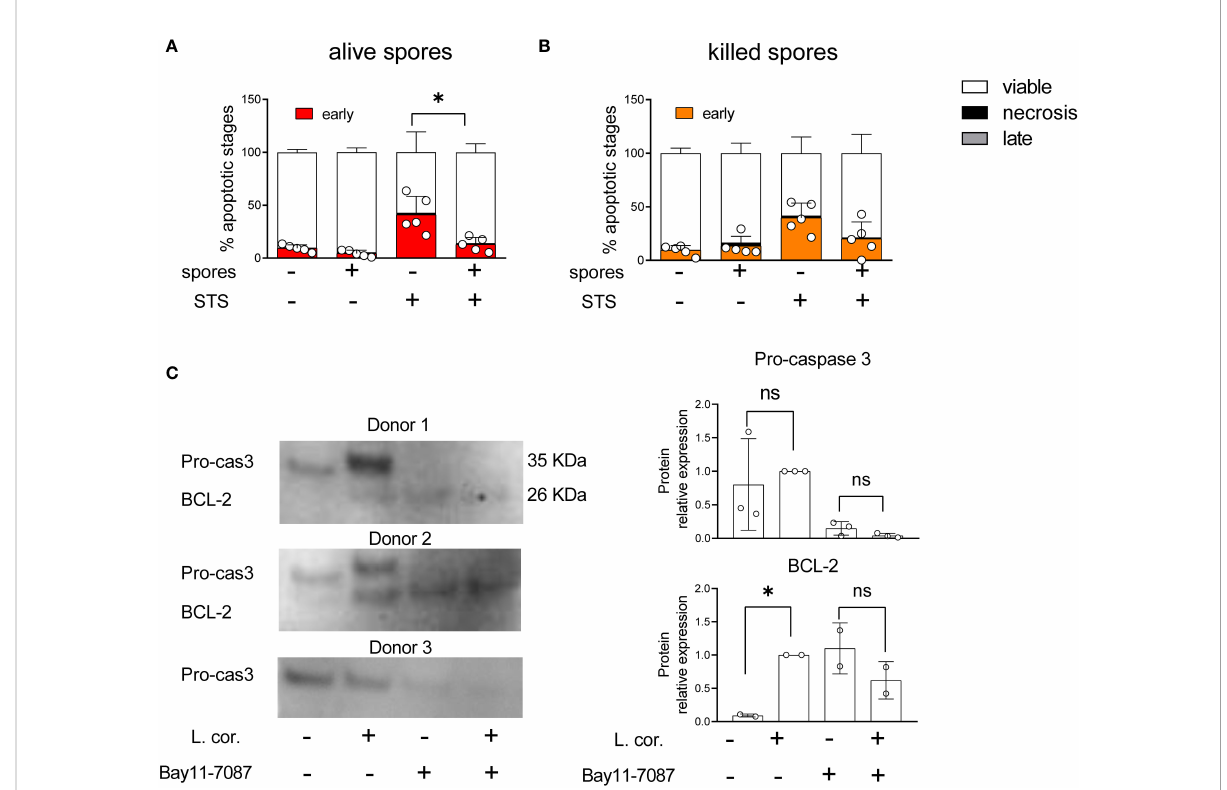
FIGURE 8 Viable spores of L corymbifera reduce early apoptosis in monocytes and trigger survival response in human monocytes. (A, B) . After phagocytosis of fungal spores, human monocytes were exposed to staurosporine (STS), a kinase inhibitor that induces apoptosis. Subsequently, monocyte apoptotic stages were evaluated by fl ow cytometry. (C) Detection of pro-caspase 3 (Pro-cas3) and the anti-apoptotic protein BCL-2 after exposure to Bay11-7087, an NF-KB inhibitor, and/or resting spores of L corymbifera . Bars represent means ± SD of data obtained from at least three independent experiments. Differences among groups were assessed by one-way ANOVA. * p < 0,05. ns indicates not signi fi